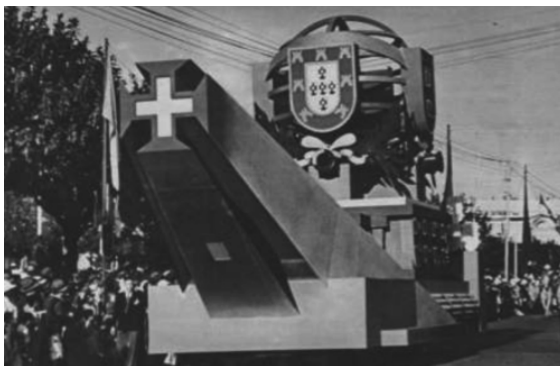
FIGURE 9 | Allegorical pageant float. no 33, o Colono e o